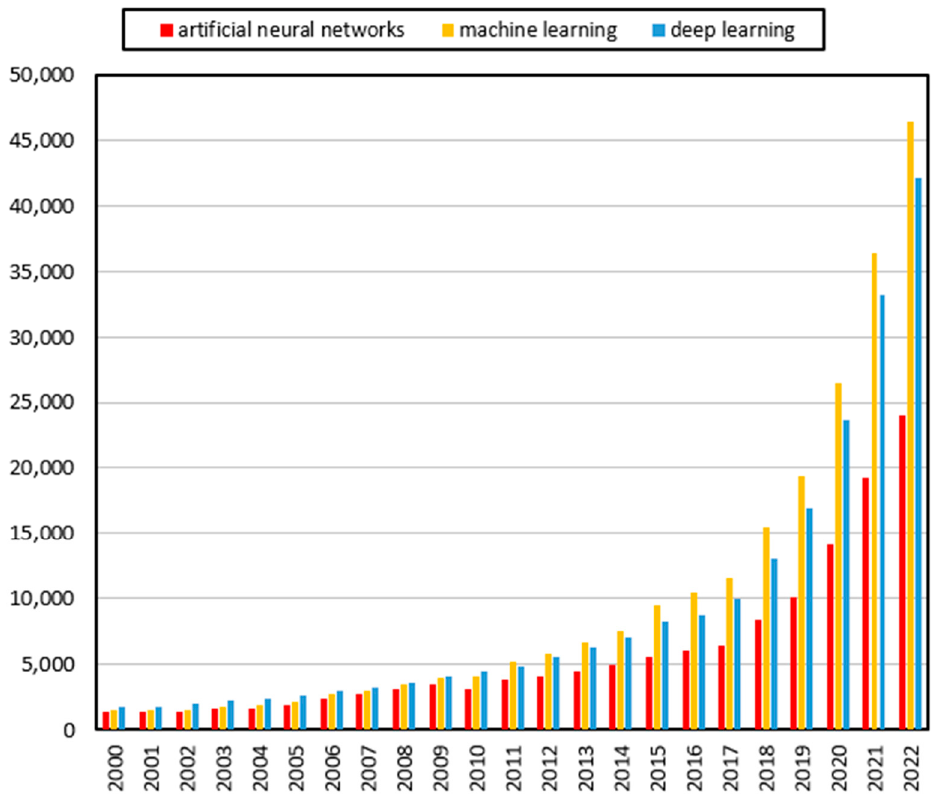
Figure 3. Number of scienti fi c articles related to arti fi cial intelligence in 2000–2022.